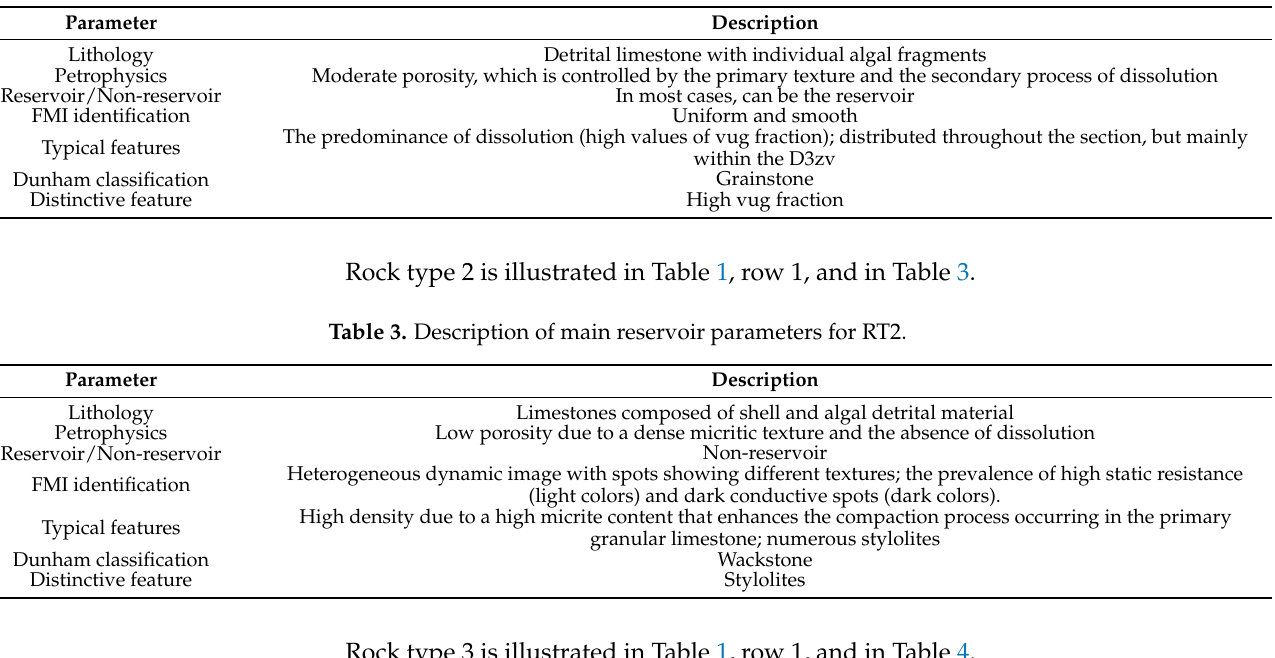
Table 2. Description of main reservoir parameters for RT1.